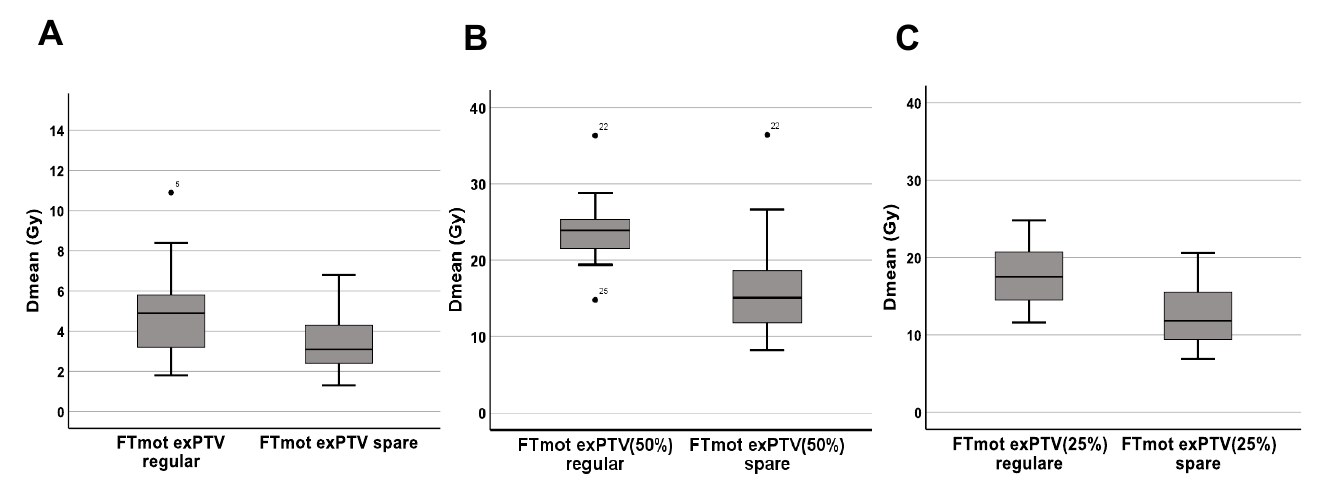
Figure 2. ( A – C ). Boxplots representing mean dose (Dmean) of different segments of DTI-FTnTMS based cortico-spinal tract beyond the planning target volume (FTmot exPTV), during regular treat- ment (FTmotexPTV regular), and after plan optimization for dose reduction (FTmotexPTV spare). Decline of dose exposition for all FTmotexPTV is minus 1.4 Gy ( p < 0.001) ( A ). For segments both beyond the PTV and within the 17.5 Gy—isodose level (FTmotexPTV50%) Dmean reduction is minus 33.0% (range, 5.9 – 57.6%) from 23.4 Gy to 15.9 Gy ( p < 0.001) ( B ). Looking at FTmot.nTMS portions both outside the PTV and within the 8.25 Gy—isodose level (FTmotexPTV25%) only, Dmean is decreased by ( − 29.2 ± 12.2%) ( p < 0.001) ( C ).